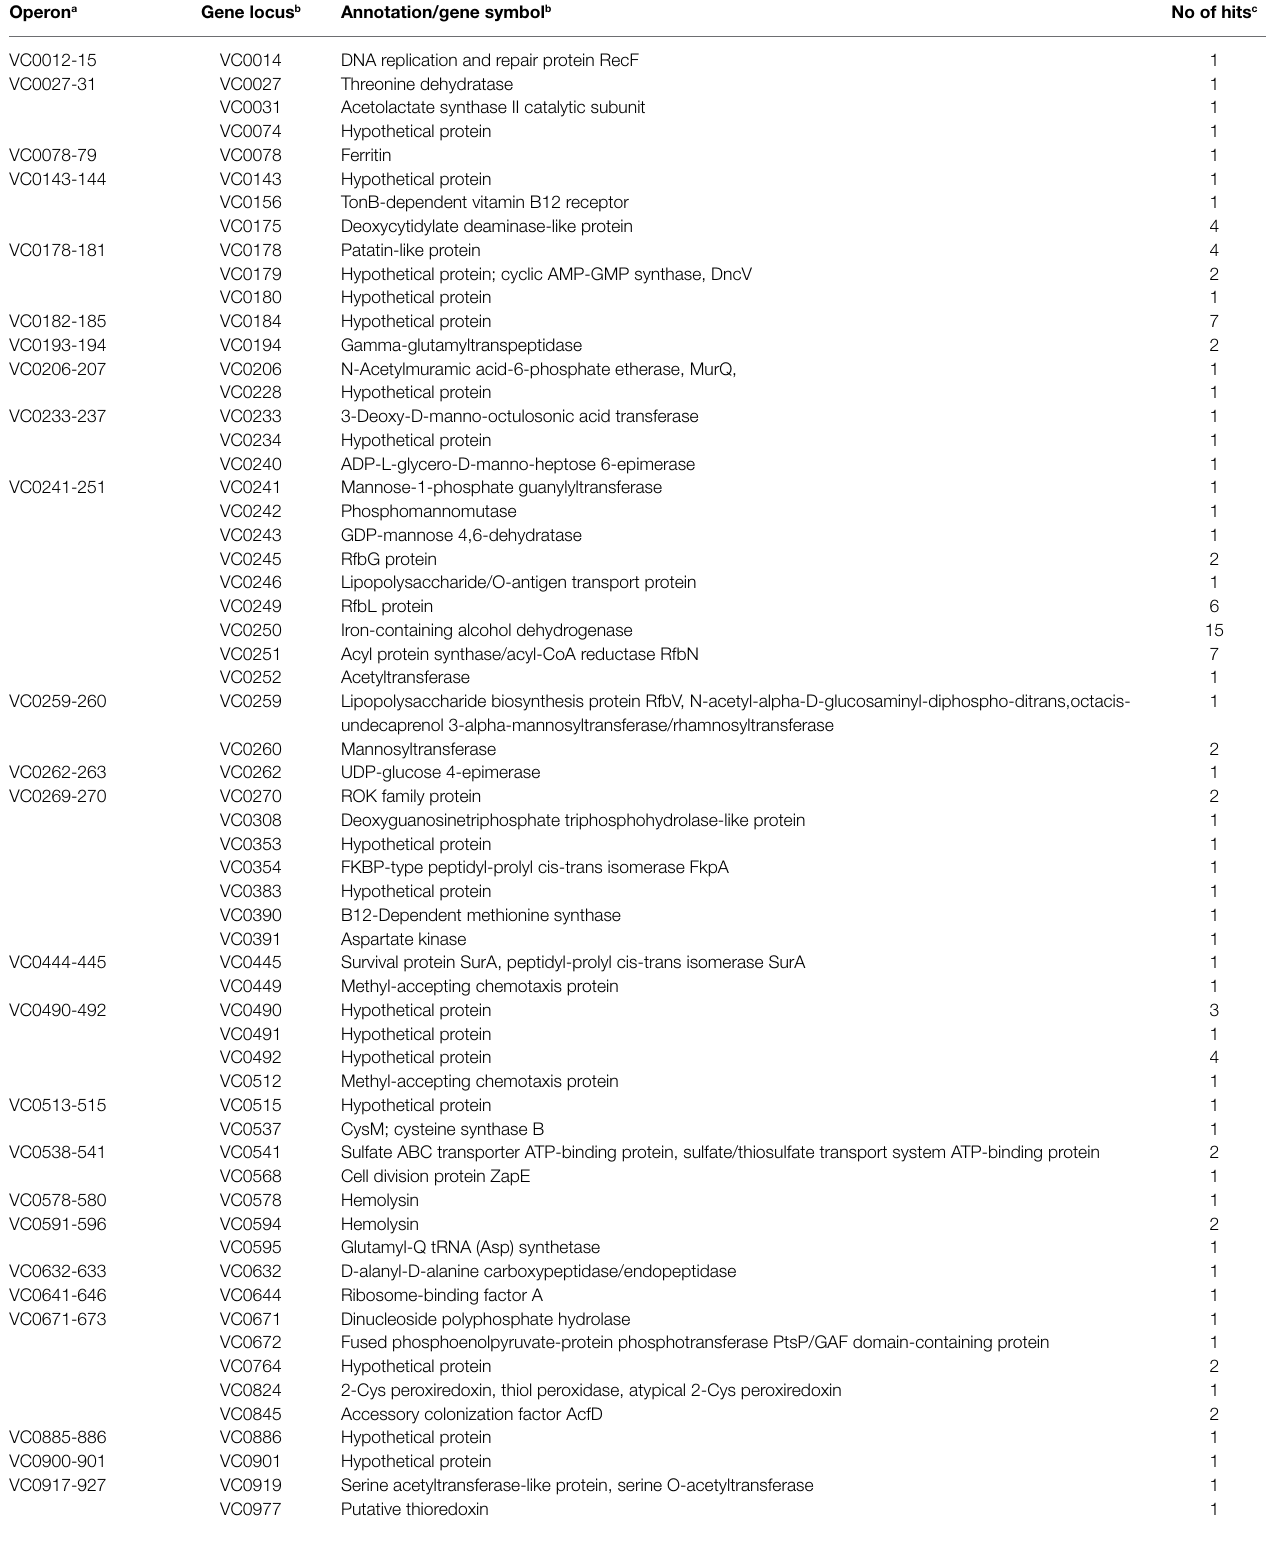
TABLE 3 | In-biofilm repressed genes of Vibrio cholerae. Operon a Gene locus b Annotation/gene symbol